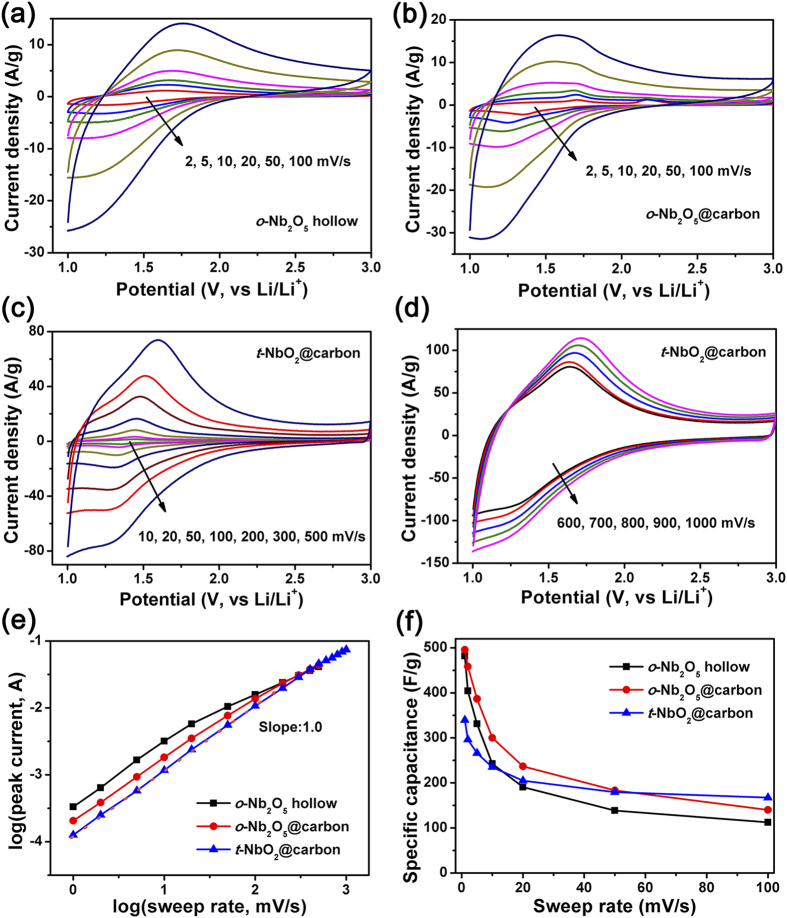
CV curves of o-Nb2O5 hollow microspheres (a), o-Nb2O5@carbon core-shell microspheres (b) and t-NbO2@carbon core-shell microspheres (c,d). The b-value from plot of log(i) versus log(v) for cathodic current peak (e). Specific capacitance versus sweep rate (f).